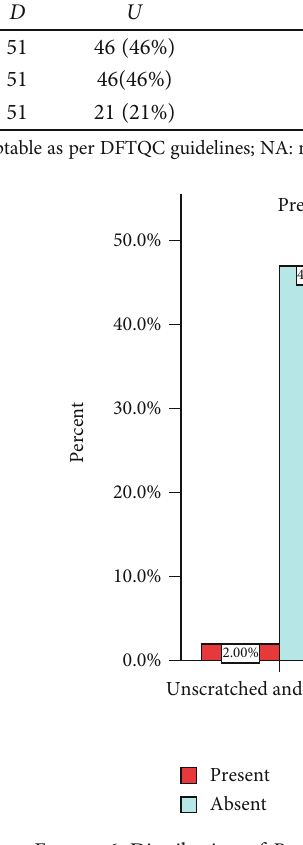
Table 3: Association between microbiological parameters (as per DFTQC guideline), the volume of bottled water. Sn Microbiological parameters